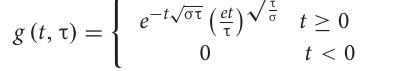
Frontiers in Neuroscience |